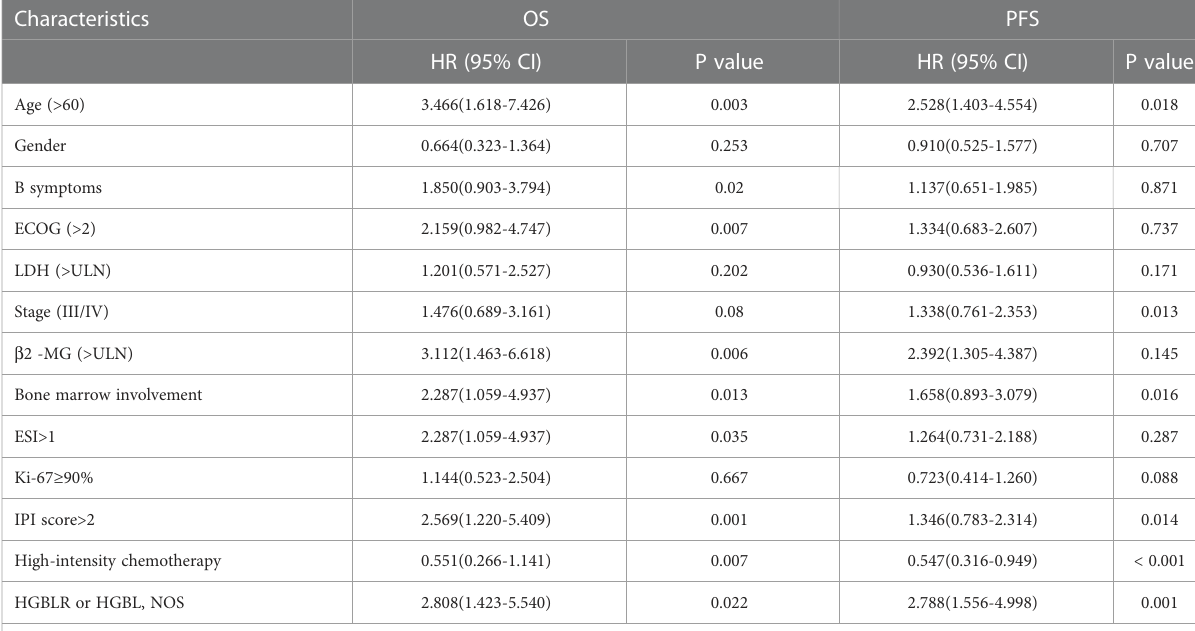
TABLE 4 Univariate analysis of risk factors associated with OS and PFS.